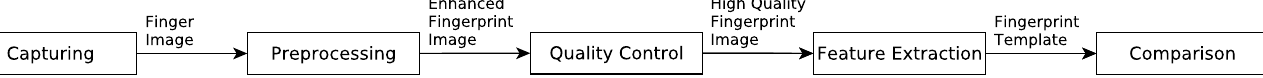
Figure 1. Overview of the most relevant steps of our proposed